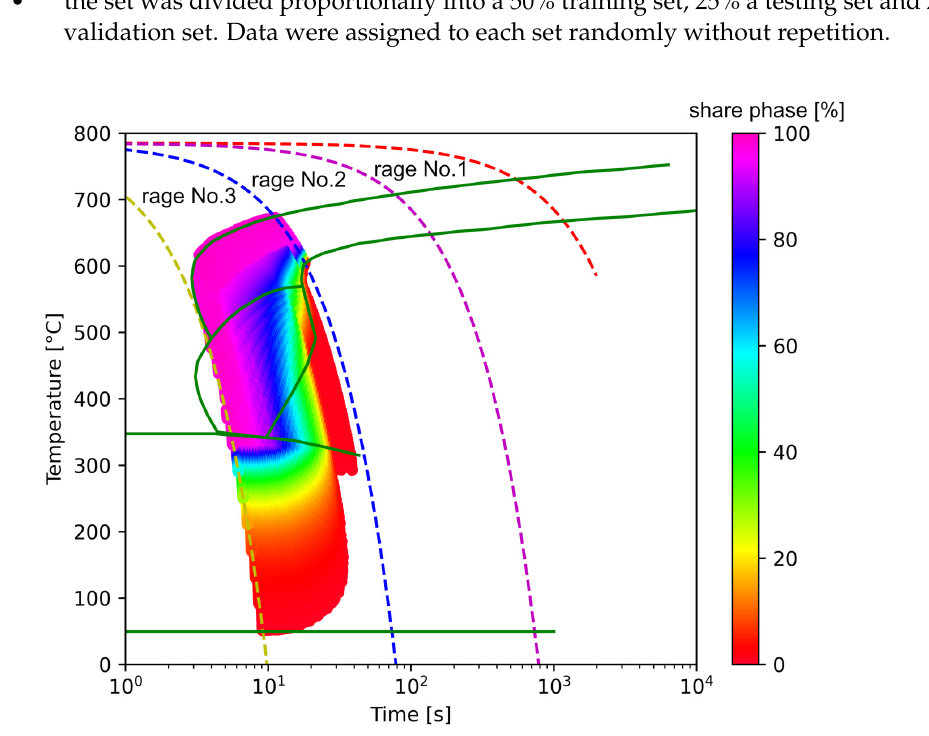
Figure 6. CTP diagram divided into analysed ranges—input/output data for RNN.